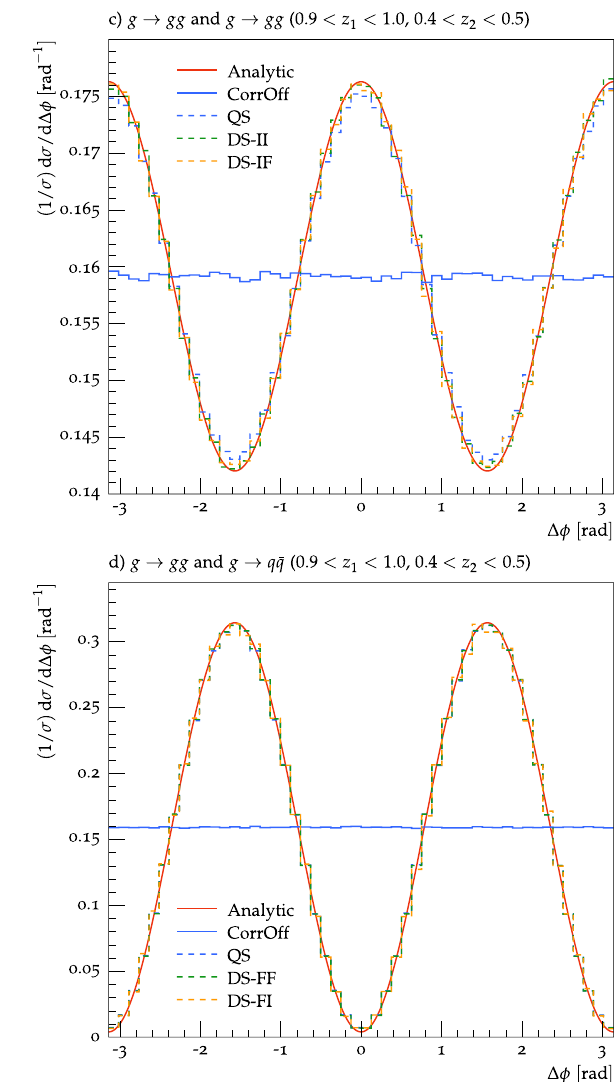
Fig. 2 The thrust at the Z-pole compared with data from the DELPHI [22] experiment. In the right panel a zoom for small 1 − T values is shown